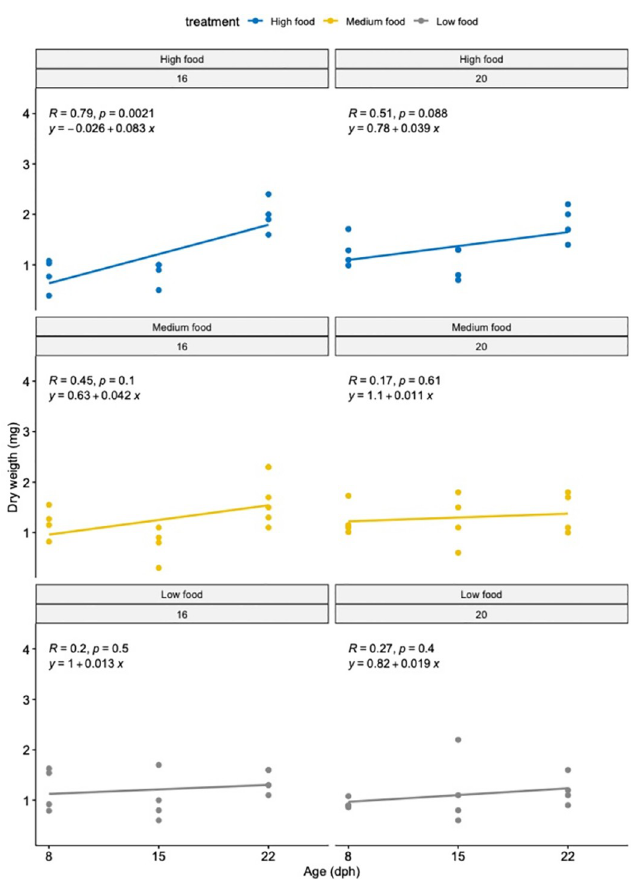
Fig 5. Dry weight of sole (mm) larvae reared at different temperatures and different feeding frequencies in experiment 2. Left panels: larvae reared at 16˚C. Right panels: larvae reared at 20˚C at high (blue), medium (yellow) and low (grey) feeding